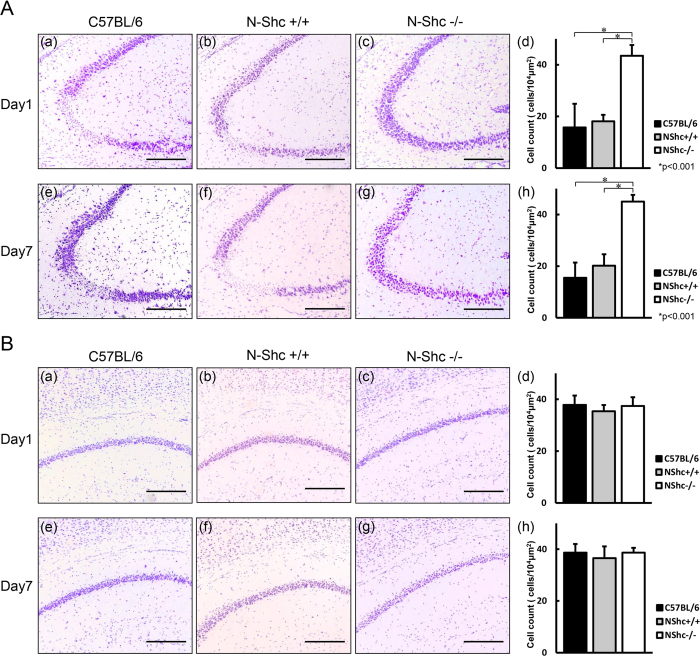
Reduction of KA-induced neuronal cell loss in the CA3 area of the hippocampus in N-Shc−/− mice.Coronal brain sections from C57BL/6, N-Shc+/+ and N-Shc−/− mice were processed by Nissl staining on 1 and 7 days after KA administration. C57BL/6 mice (a) day1 n = 6, (e) day7 n = 4; N-Shc+/+ mice (b) day1 n = 3, (f) day7 n = 3; and N-Shc−/− mice: (c) day1 n = 7, (g) day7 n = 6. Neuronal cell loss was observed in the pyramidal cell layer of the CA3 area of the hippocampus in C57BL/6 and N-Shc+/+ mice on day1 (A–a,b) and day7 (A–e,f) after KA administration. In contrast, neuronal cell loss in the CA3 area was prevented in N-Shc−/− mice on day1(A–c) and day7(A–g). Number of pyramidal cells in the CA3 area was significantly reduced in C57BL/6 and N-Shc+/+ mice as compared with those in N-Shc−/− mice (15.7 ± 9.1, 18.1 ± 2.5 and 43.5 ± 4.2 cells/104 μm2 on day1; 15.5 ± 5.9, 20.2 ± 4.4, and 45.0 ± 2.6 cells/104 μm2 on day7; respectively, p < 0.001) (A–d,h). Minimal, or no neuronal cell loss were observed in the CA1 area of the hippocampus in three groups on day1 (B–a,b,c) and day7 (B–e,f,g) after KA administration. Number of pyramidal cells in the CA1 area of the hippocampus showed no significant difference among C57BL/6, N-Shc+/+ and N-Shc−/− mice (37.8 ± 3.6, 35.4 ± 2.4, and 37.4 ± 3.4 cells/104 μm2 on day1; 38.7 ± 3.3, 36.5 ± 4.5, and 38.6 ± 1.9 cells/104 μm2 on day7; respectively, p > 0.05) (B-d, h). Scale bars = 200 μm.